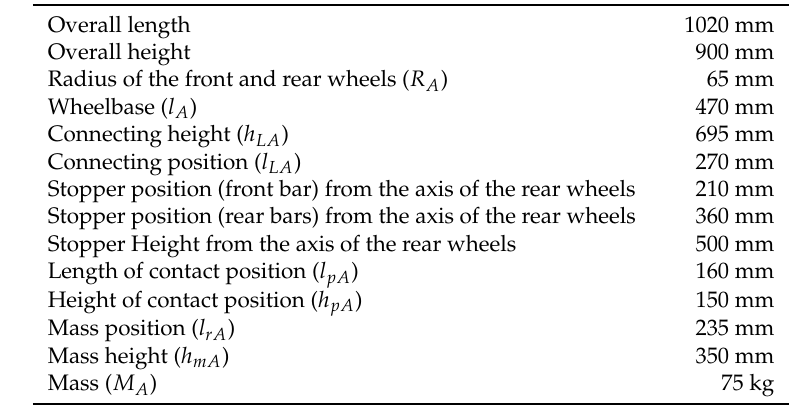
Table A2. Specifications of the hand